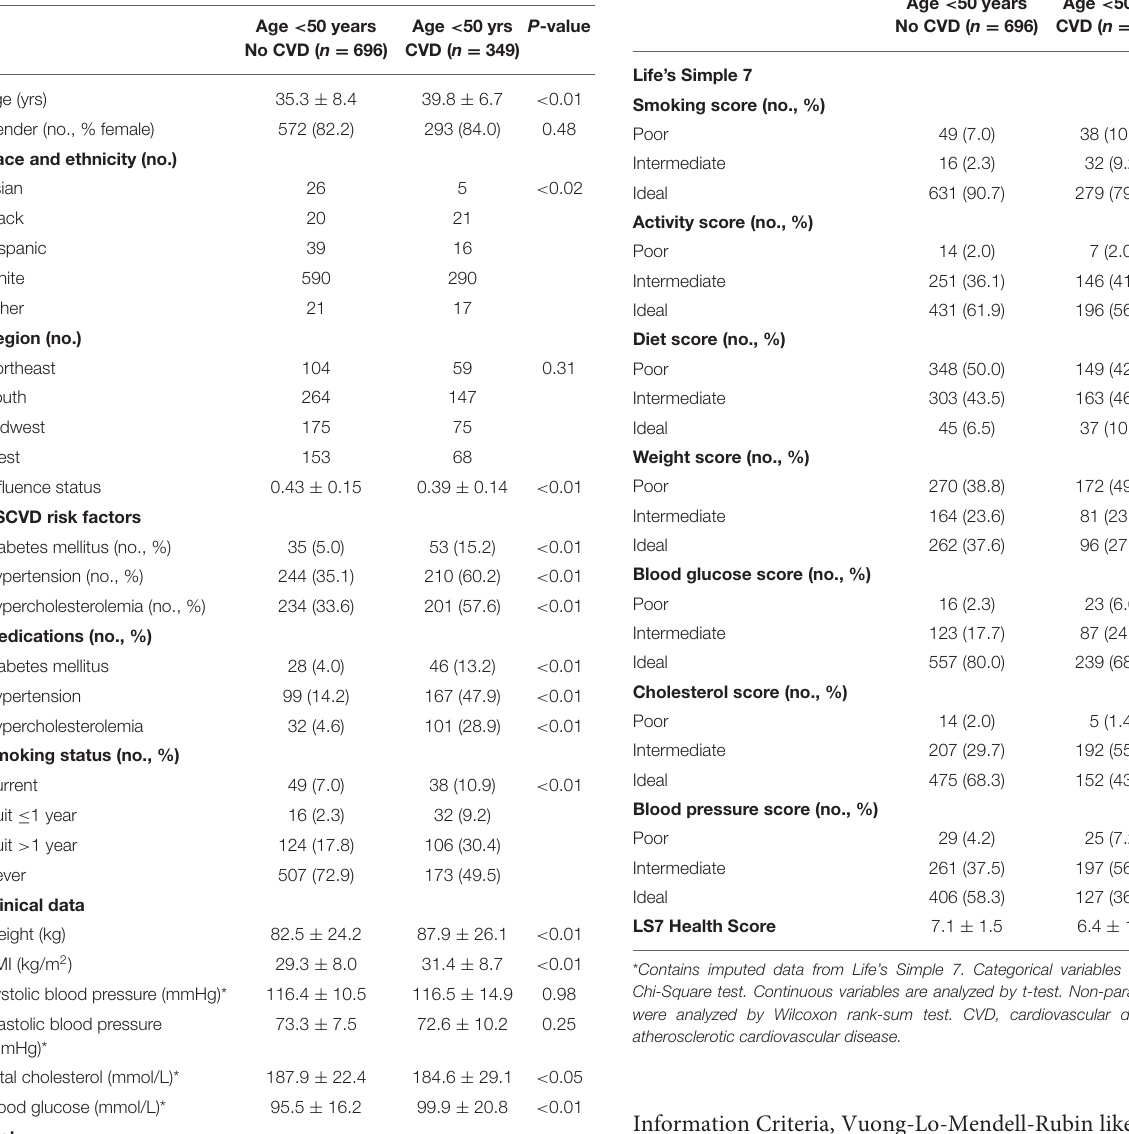
TABLE 1 | Self-reported demographics, clinical, and Life’s Simple 7 data for participants age < 50